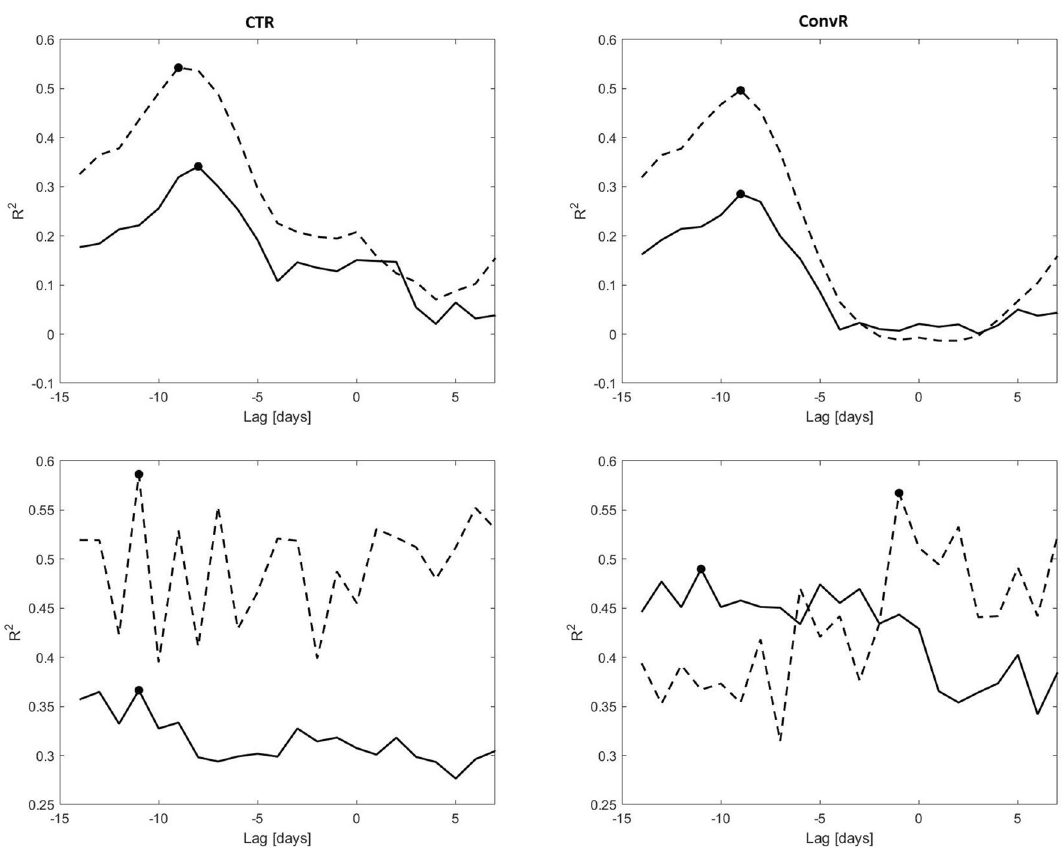
2 Figure 2. Coefficient of determination ( R ) as a function of lag for different parameters of the advertising system and indications of the pandemic. The top figures show data for the entire country, while the bottom are at a city level. The left column shows the correlation with CTR and the right column with ConvR. Bold lines denote case rates and dotted lines hospitalization rates. The dots show the highest correlation for each curve. Negative lag indicates that data from the advertising system leads that of the pandemic. Note that vertical axes have different values for country- and city-level graphs.